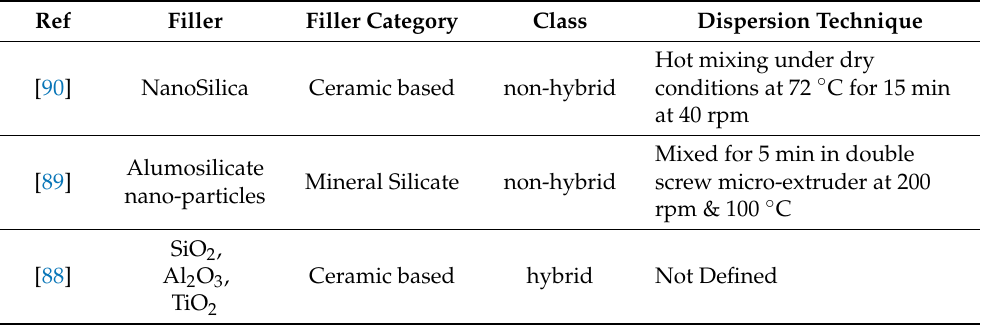
Table 7. Summary of various dispersion techniques used to uniformly disperse the nano-fillers in the epoxy matrix.